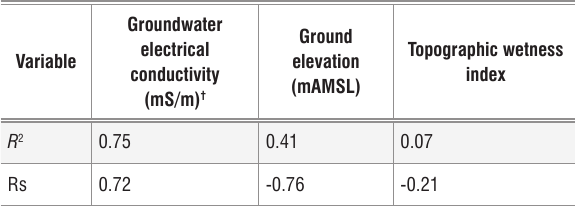
Correlation of regolith salt storage (t/ha) with catchment variables